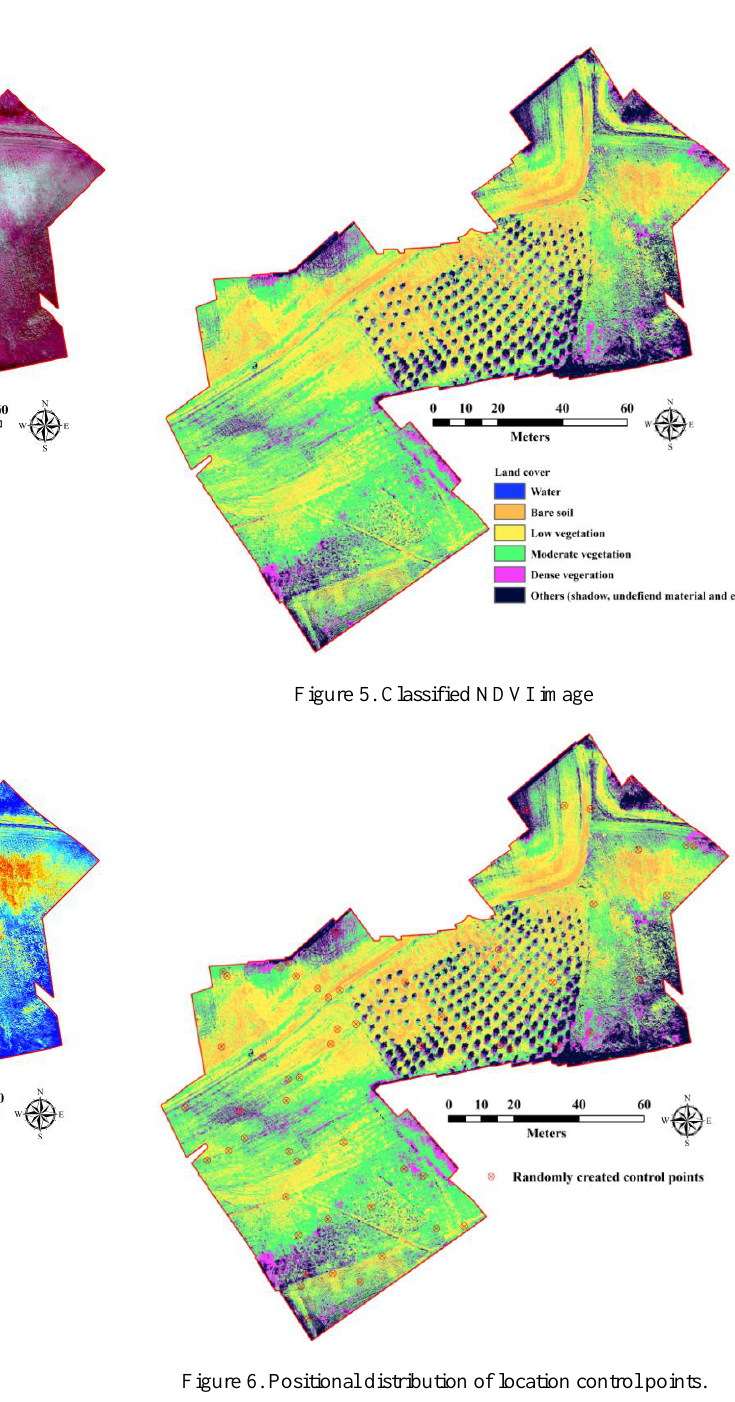
Figure 4b. NDVI image